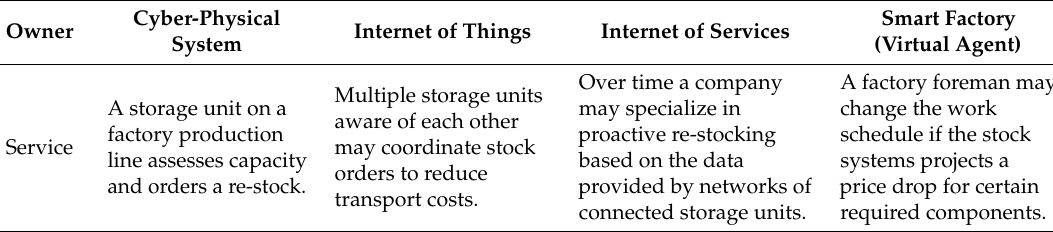
Table 1. Applying the Industry 4.0 toolset in